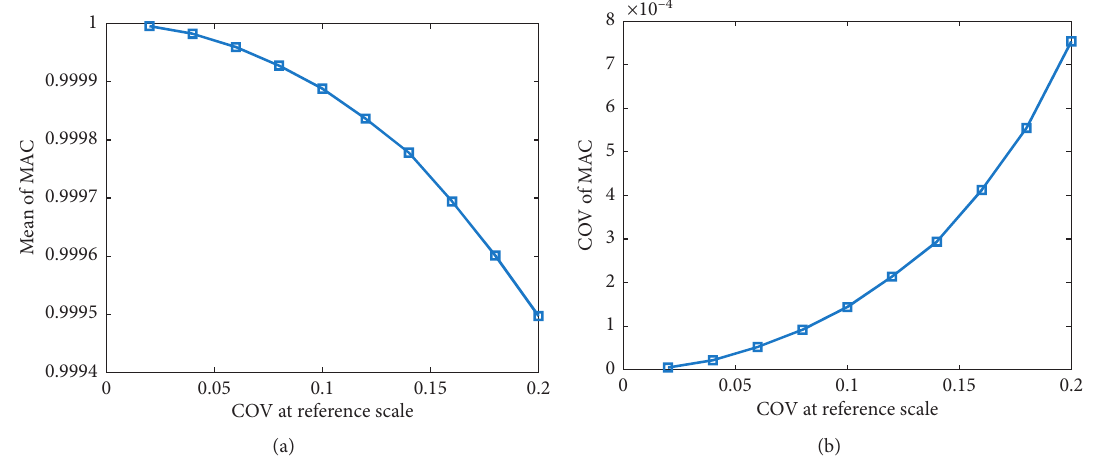
Figure 13: Statistics of the first-order MAC values for different values of COV at the reference scale: (a) mean and (b) COV. The mesh size is 4 times the reference size.